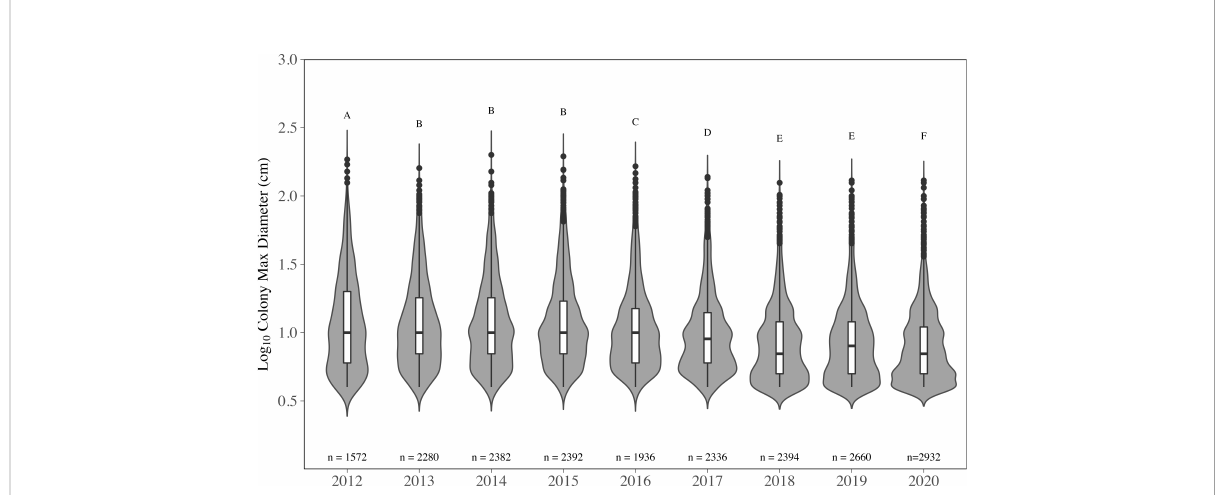
FIGURE 5 Colony maximum diameter by year for all species combined. with the y-axis on a Log 10 scale. Numbers above the year are the total number of stony coral colonies. The grey areas indicate the kernel density distribution of maximum colony diameter, where the wider the plot is the higher the probability that members of the population will take on that given value and skinnier sections have lower probabilities. The inset boxplots represent the median (solid middle bars), interquartile range (box length), and maximum and minimum values (whiskers) of colony maximum diameter. Data points that fall outside the boxplot are considered outliers. Different letters above the violins indicate signi fi cant differences in maximum colony diameter between years (p < 0.05, KS